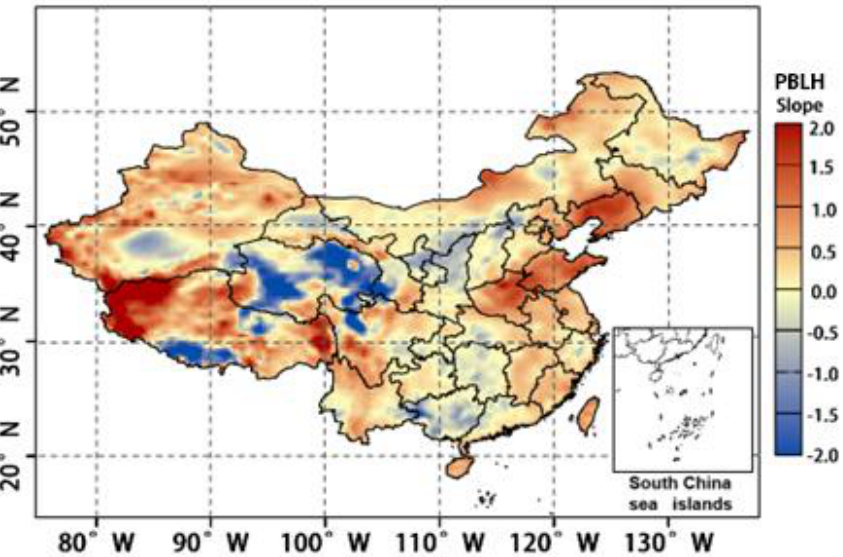
Figure 15. Variation map of the annual average spatial distribution of PBLH from 2005 to 2020.